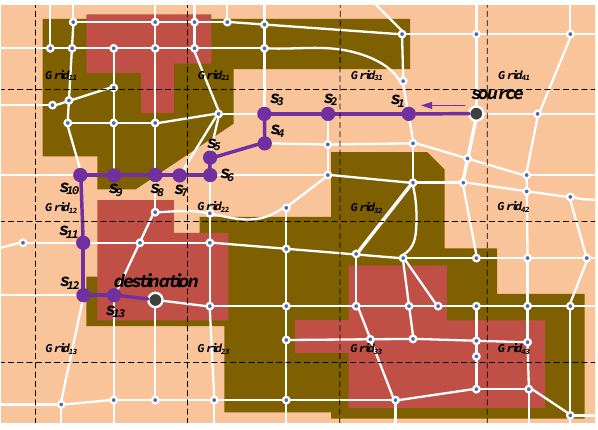
Figure 7. Situational grid heuristic search path